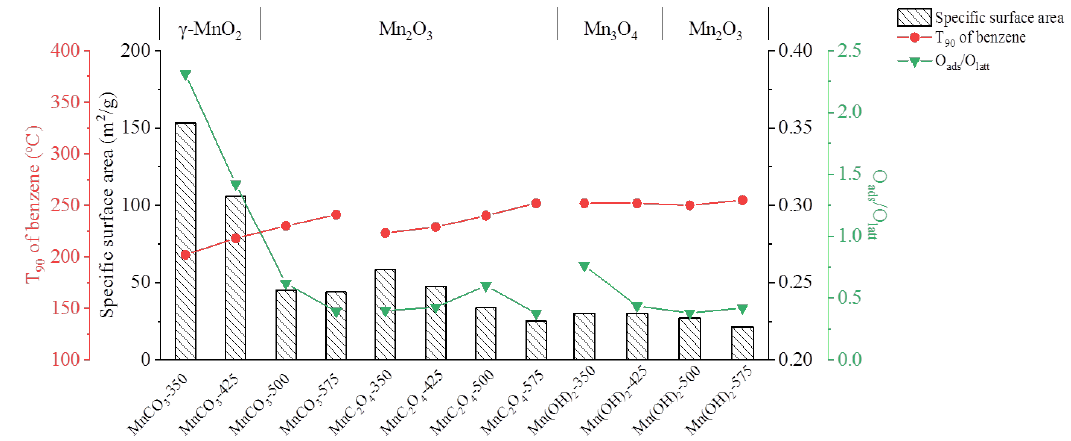
Figure 7. Summary of catalytic properties for the manganese oxide catalysts.